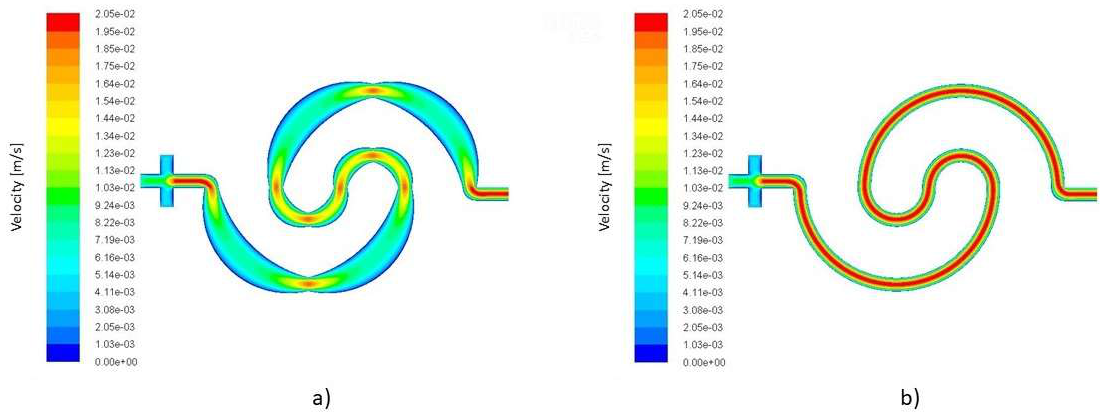
Figure 6. ( a ) Velocity contours of the one loop mixer with 10% expansion and ( b ) the one mixer without expansion parts. The operating condition for both mixers is identical ( Re 1.0).